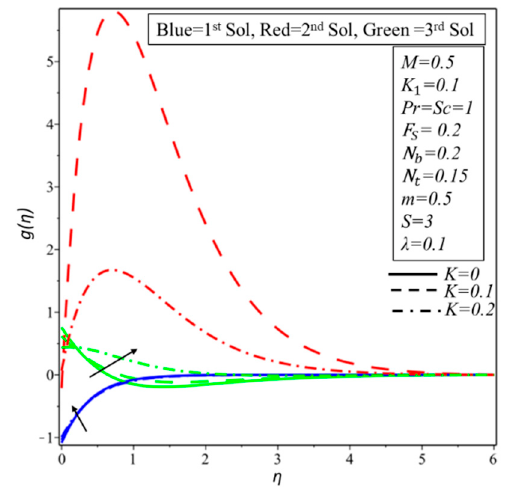
Figure 8. Microrotation profiles for increasing values of K .